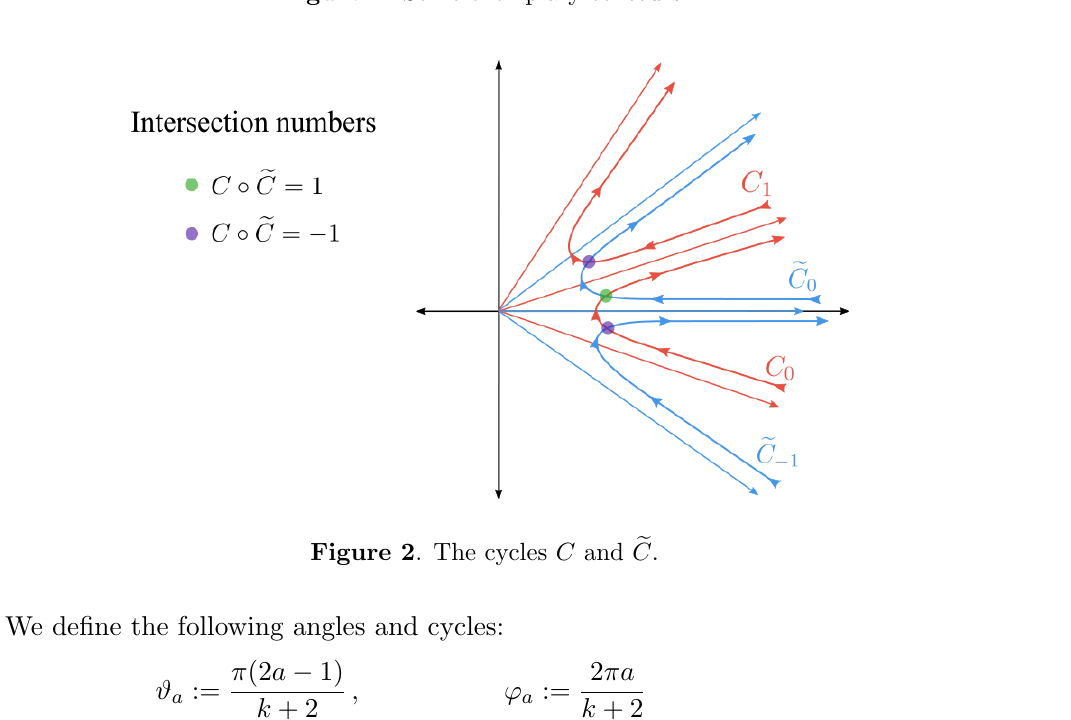
Figure 1 . Some exemplary contours.